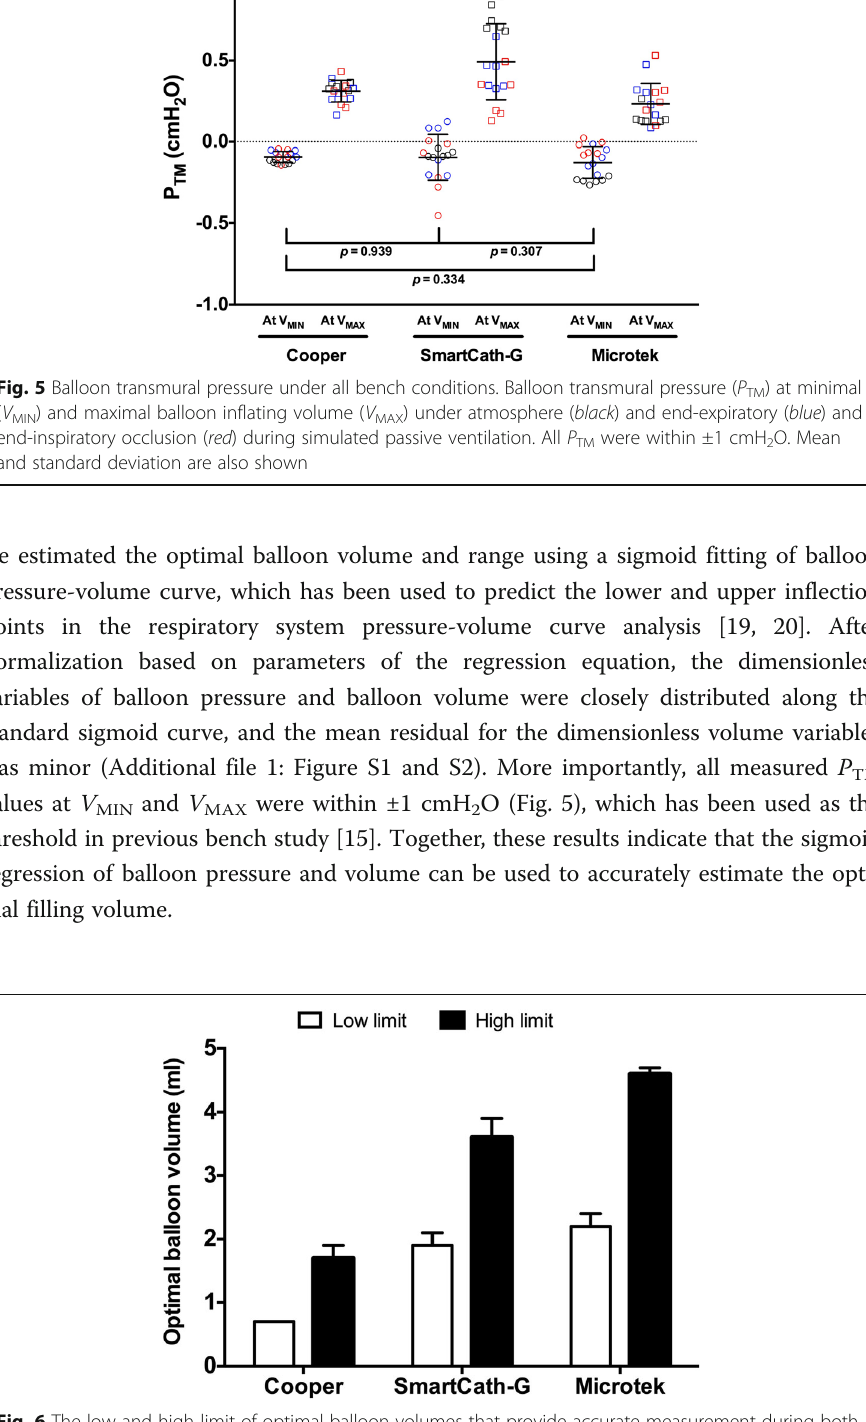
Fig. 6 The low and high limit of optimal balloon volumes that provide accurate measurement during both end-expiratory and end-inspiratory occlusion. The low and high limits were defined as the minimal and maximal balloon inflating volume that provided accurate measurement during both end-expiratory and end-inspiratory occlusion